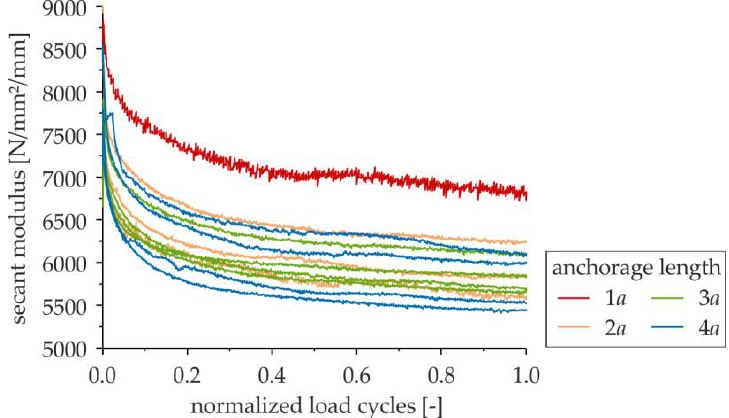
Figure 12. Comparison of the normalized development of the secant modulus of different anchorage lengths at similar load level (here: σ min / σ max = 50%/85%).